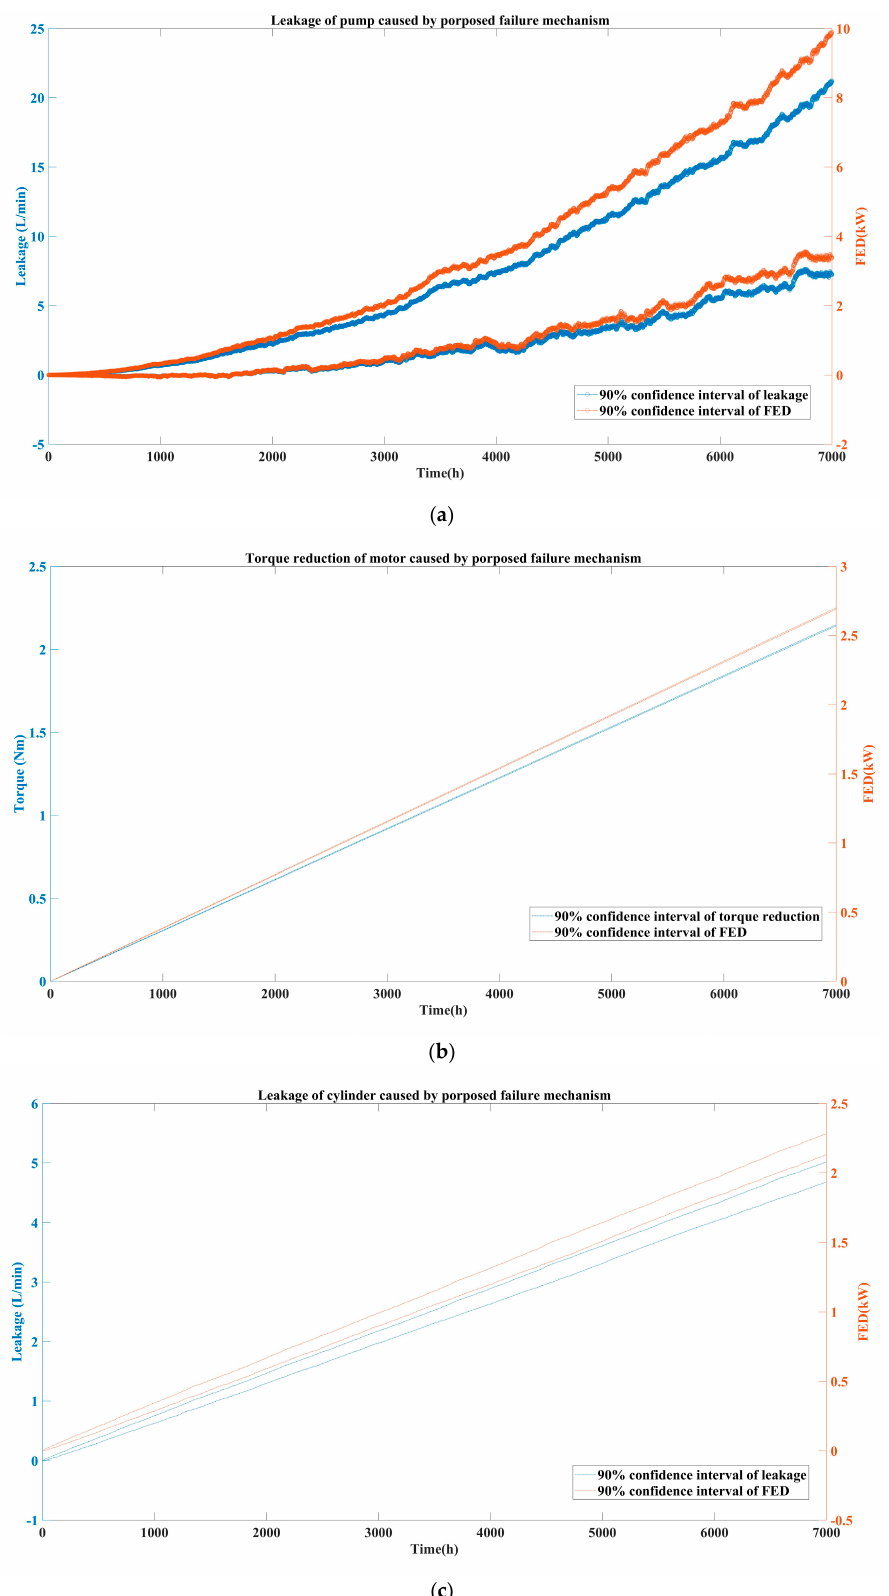
Figure 9. Degradation process of each ETU with 90% confidence interval: ( a ) pump; ( b ) motor; ( c ) cylinder.